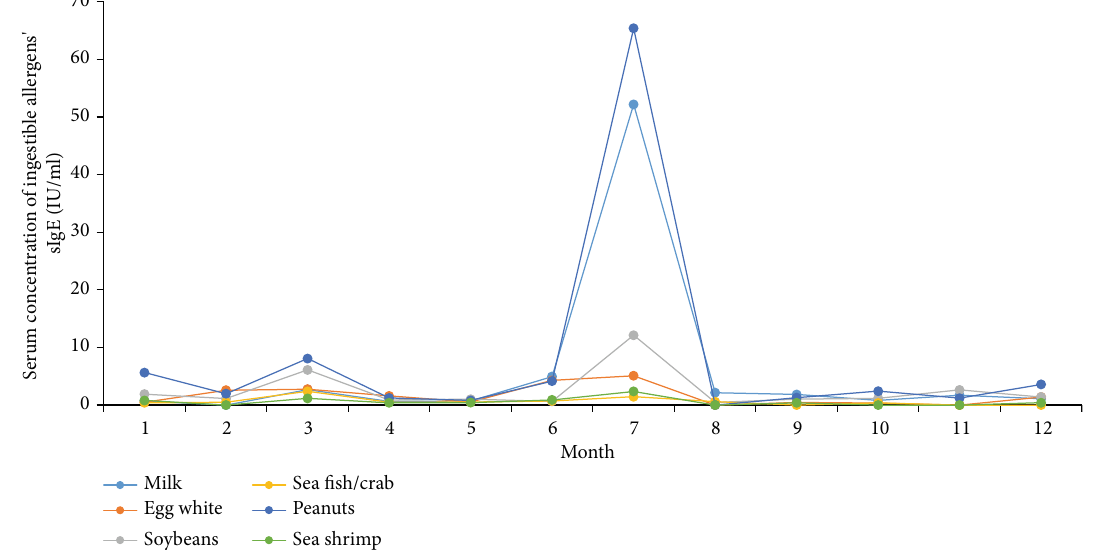
Figure 6: sIgE levels of 6 ingestible allergens in di ff erent